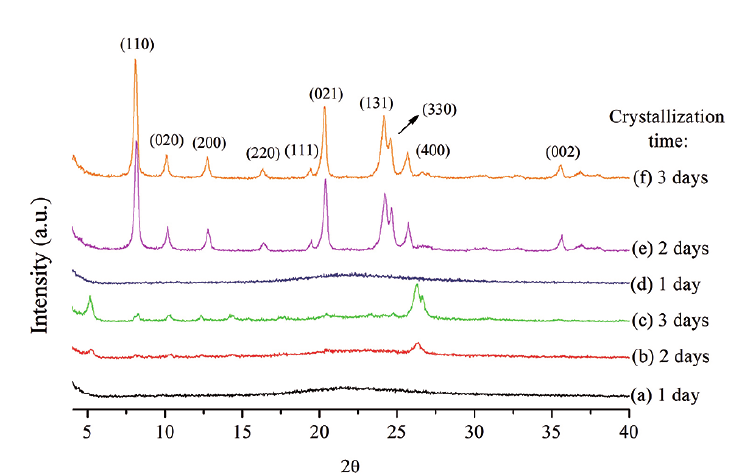
Figure 2: X-ray diffractograms of zeolites obtained by method A (using diaminooctane as OSDA) with reaction times of (a) 1 day, (b) 2 days, (c) 3 days in static mode, and (d) 1 day, (e) 2 days, and (f) 3 days with